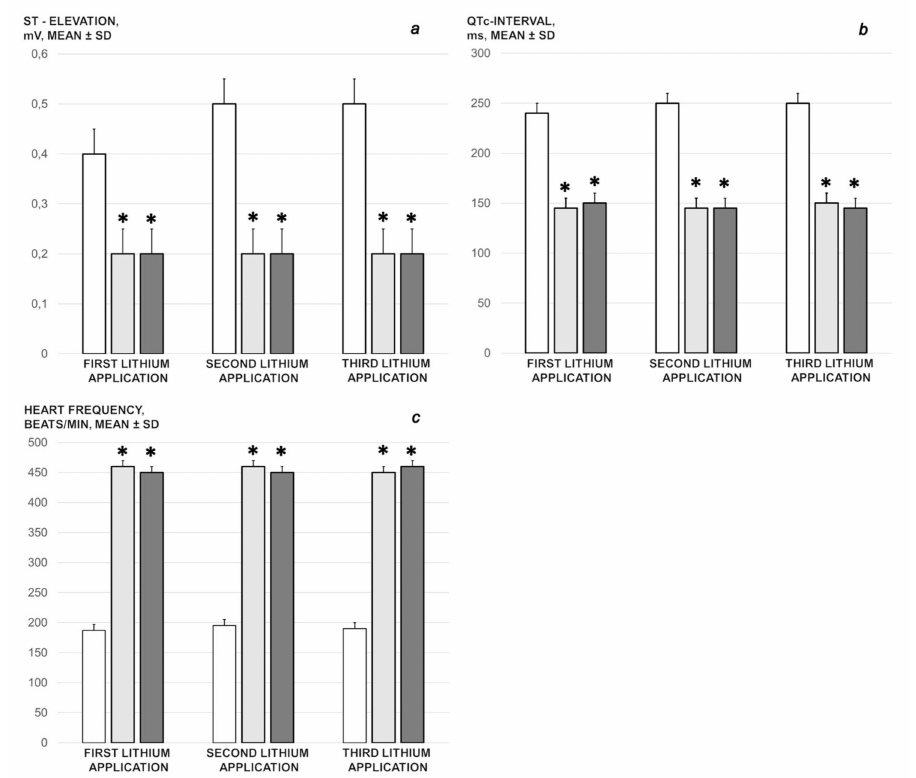
Figure 2. ECG changes: ST-elevation, mV, ( a ); QTc-interval prolongation, ms ( b ); heart frequency ( c ), beats/min; after first, second, and third lithium sulphate administration (500 mg/kg/day in- traperitoneally for 3 consecutive days). BPC 157 10 µ g/kg (light gray bars), 10 ng/kg (dark gray bars); saline 5 mL/kg (white bars) given intraperitoneally after each of the lithium administrations. Six rats/group/interval. Means ± SD, * p < 0.05, at least, vs.